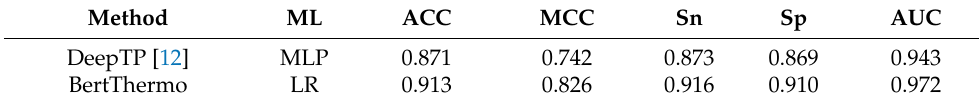
Table 5. Ten-fold cross-validation metrics for BertTherm reimplemented by a dataset from DeepTP.